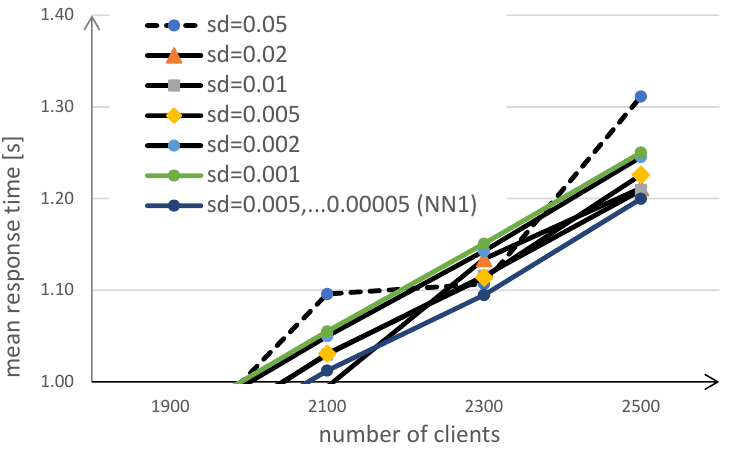
Figure 7. Charts of the average request service time for different values of the standard deviation used for the modification of weights.